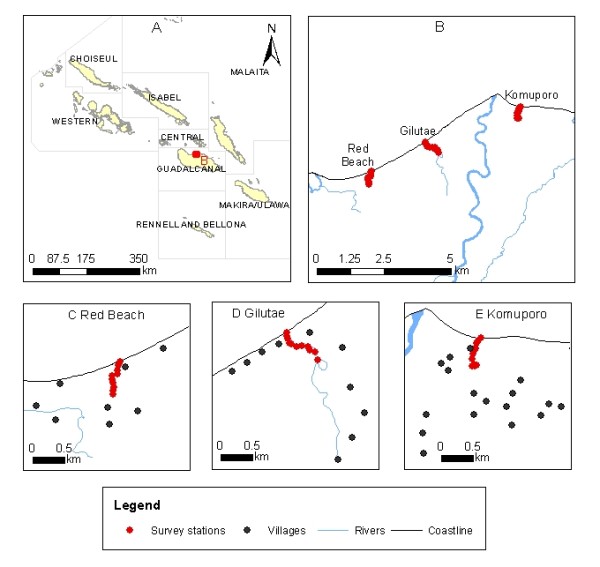
Map of the study sites. (A) Map of the Solomon Islands indicating the study area on Guadalcanal province. (B) North Guadalcanal showing the three study sites. (C, D, E) The relative locations of each of the dammed brackish water stream and surrounding villages.